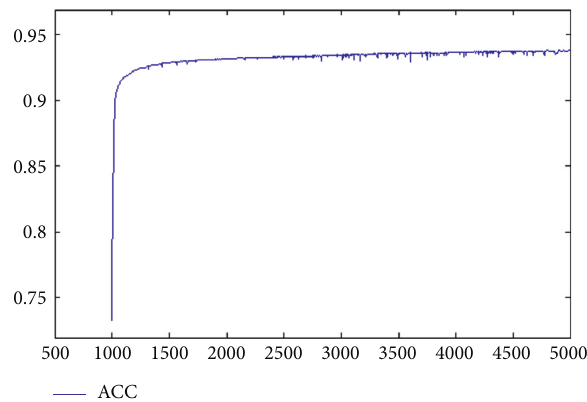
Figure 13: RNN-GCN ACC